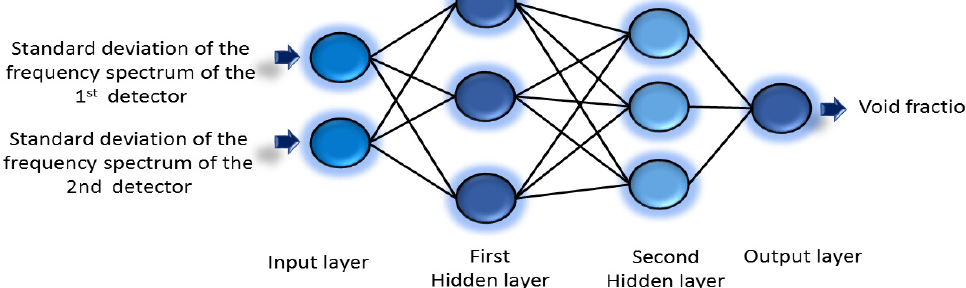
Figure 12. The architecture of the adopted network for void fraction prediction. The network performances for void fraction measurement for training and testing data samples are indicated in Figures 13 and 14, respectively.